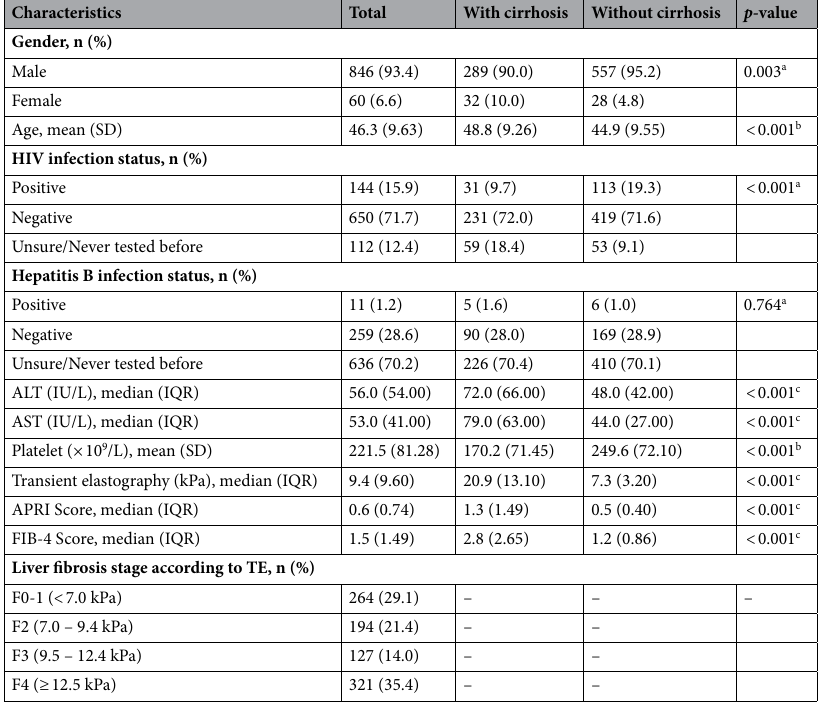
Table 1. Baseline characteristics of the 906 individuals evaluated. SD Standard deviation, APRI aspartate aminotransferase to platelet ratio index, FIB4 fibrosis 4 index, ALT alanine transaminase, AST